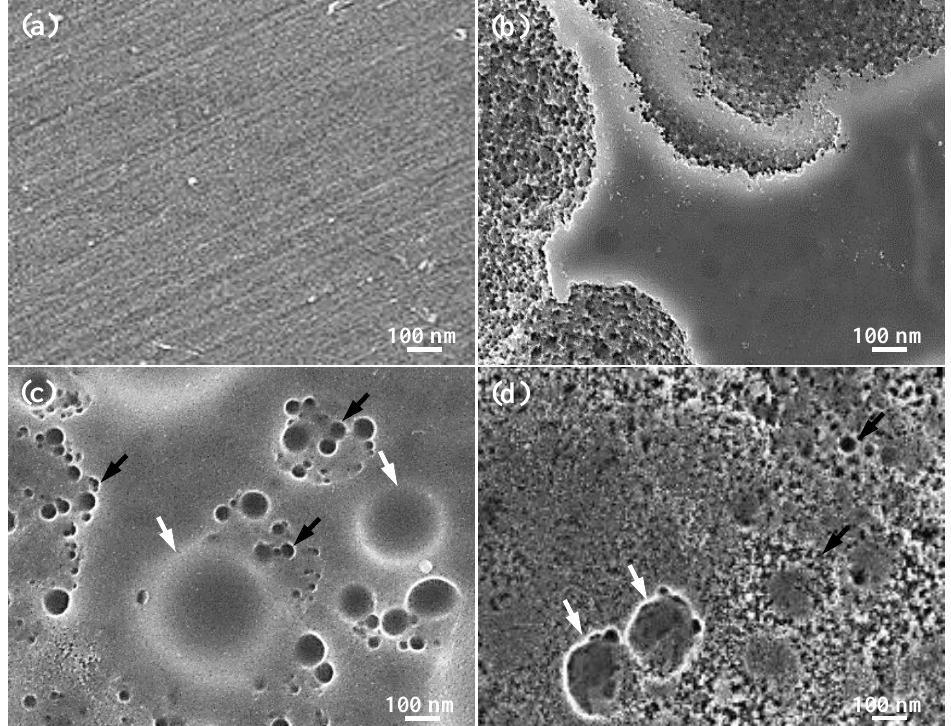
Figure 2. FE-SEM micrographs of the unmodified 316L biomedical stainless steel (BSS) specimen and 316L BSS following various anodized voltages for 5 min: ( a ) unmodified, ( b ) anodized at 3 V, ( c ) anodized at 5 V, and ( d ) anodized at 8 V. (Micropores and nanopores are indicated by white and black arrows, respectively).